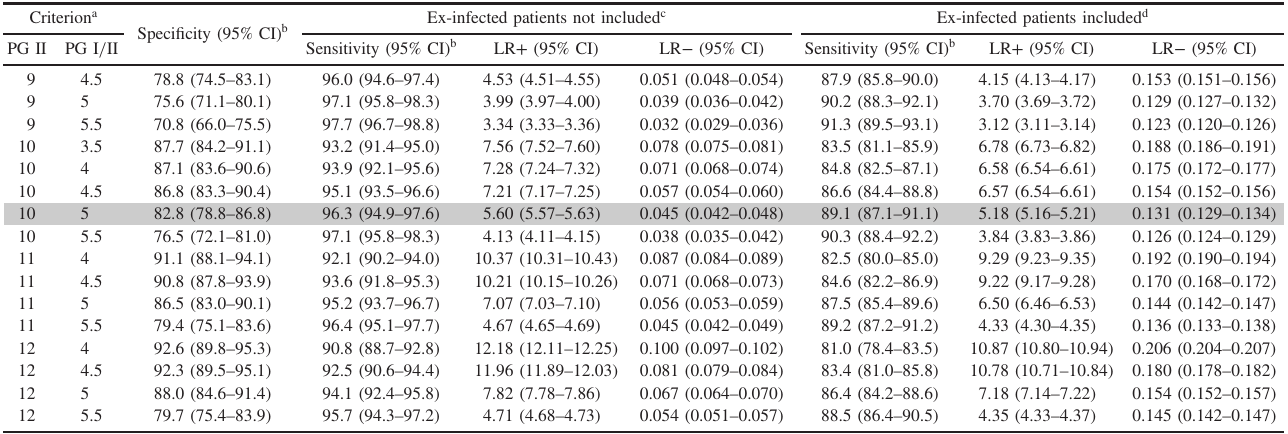
Table 4. Speci fi city and sensitivity for H. pylori infection under each criterion for measures obtained with the CLIA method Criterion a